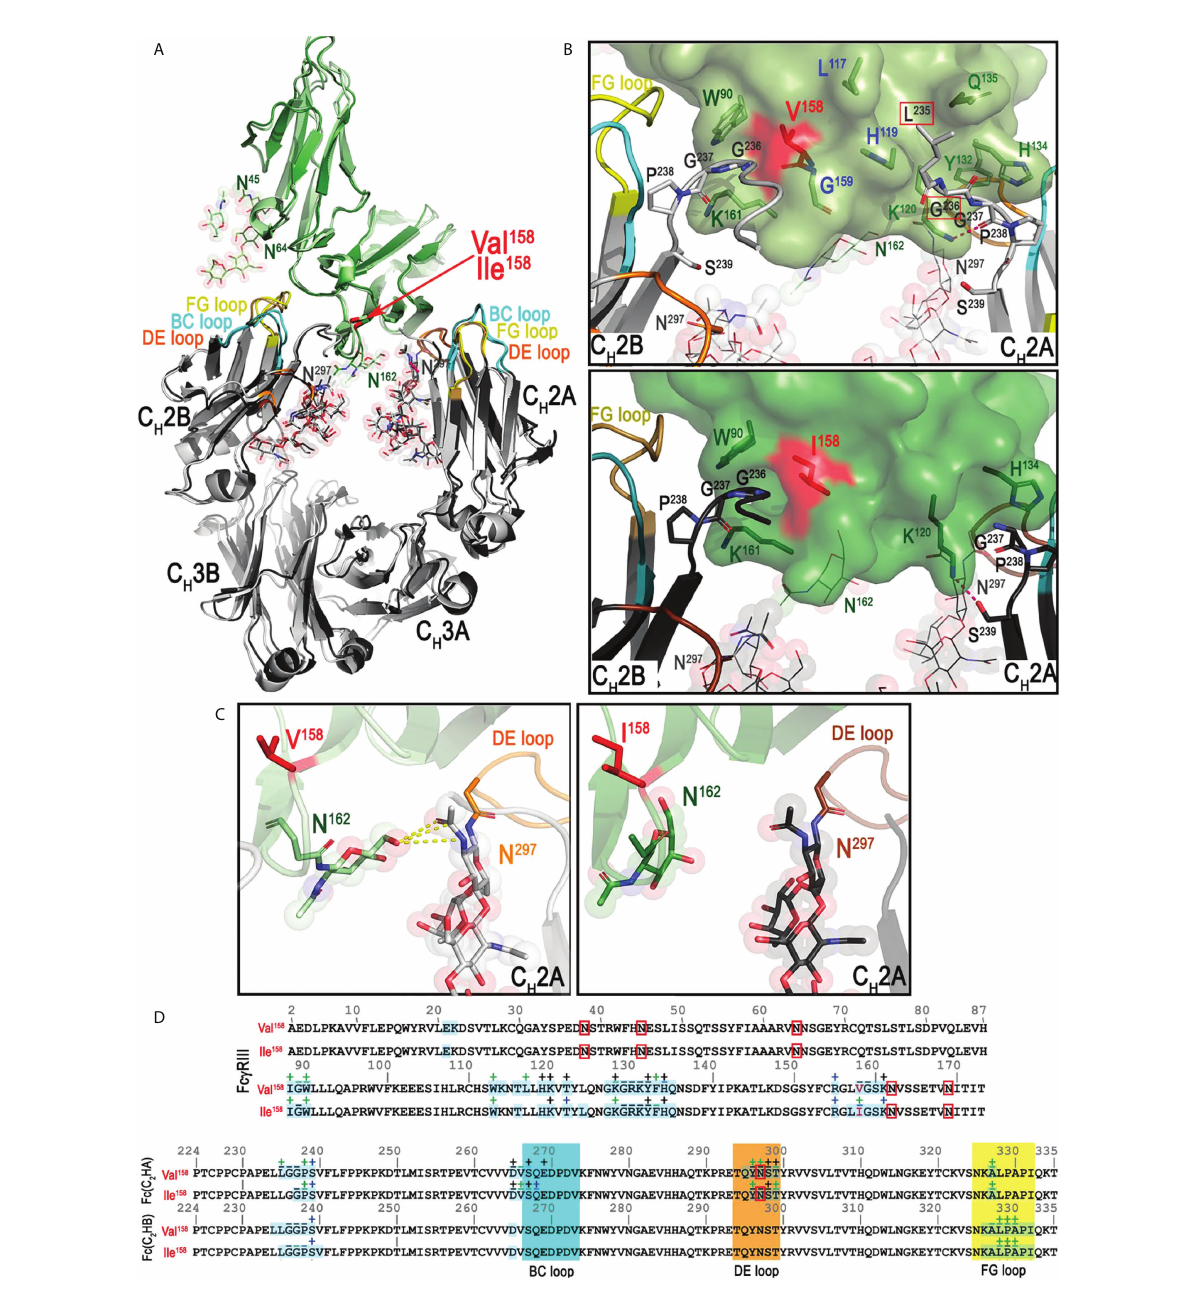
FIGURE 5 Structural comparison of the Mm Fc g RIII(Val 158 )-Fc(IgG1) and Mm Fc g RIII(Ile 158 )-Fc(IgG1) complexes. (A) Superimposition of the two Mm Fc g RIII- Fc(IgG1) structures shown in a ribbon diagram with colors indicated as in panel A of Figure 1. The two heavy chain monomers are labeled as A and B chains. The interfaces (B) and the blow up views of the hydrogen bond networks (C) of the interactions between Mm IgG1-Fc with Mm Fc g RIII(Val 158 ) (top panel B , left panel C ) and Mm Fc g RIII(Ile 158 ) (bottom panel B , right panel C ) with colors as in panel (A) The Mm Fc g RIII receptors are shown as a molecular surface. The contact residues of IgG1-Fc and Fc g RIII receptors are shown as sticks. Additional residues in the Mm Fc g RIII(Val 158 )-Fc(IgG1) complex for Fc g RIII(Val 158 ) and Fc(IgG1) that contribute to the binding are colored in blue or are indicated with red boxes, respectively. (D) Pairwise sequence alignment of the two Mm Fc g RIII receptors (top panel) and the two Mm IgG1-Fc (bottom panel). The glycosylation residues are in red boxes. The BC, DE, and FG loops are shaded in cyan, orange and yellow, respectively. Buried surface residues are determined by PISA and shaded with blue. Contact residues de fi ned by a 5 Å cutoff are marked above the sequence with (+) for side chain and (-) for main chain to indicate the type of contact. Contact types are colored as follows: hydrophilic (green), hydrophobic (blue) and both